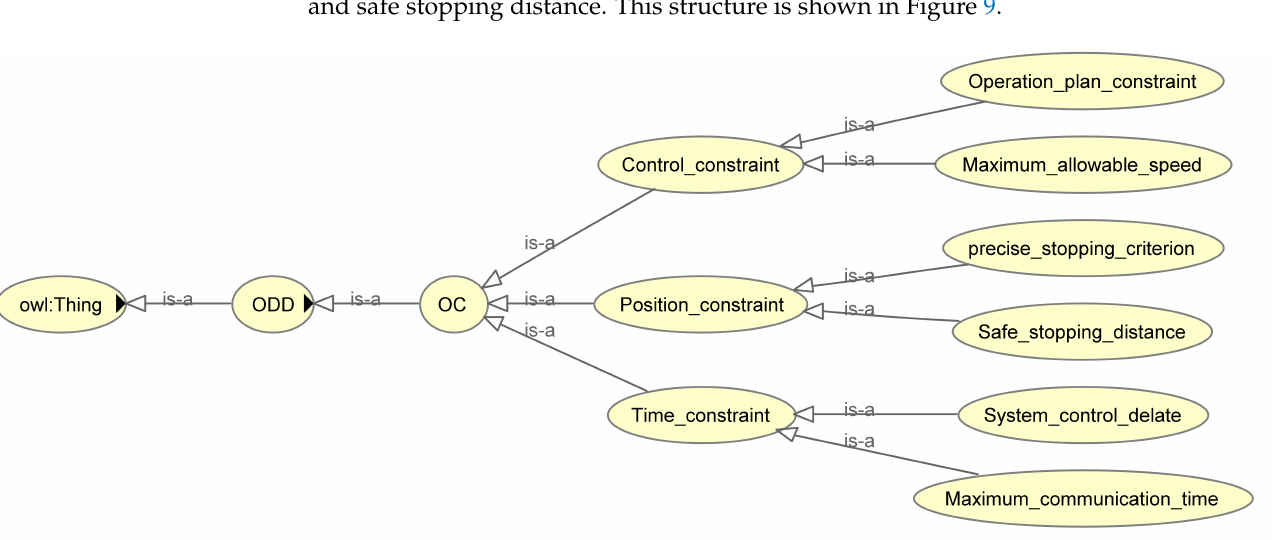
Figure 9. Structure diagram of the operational